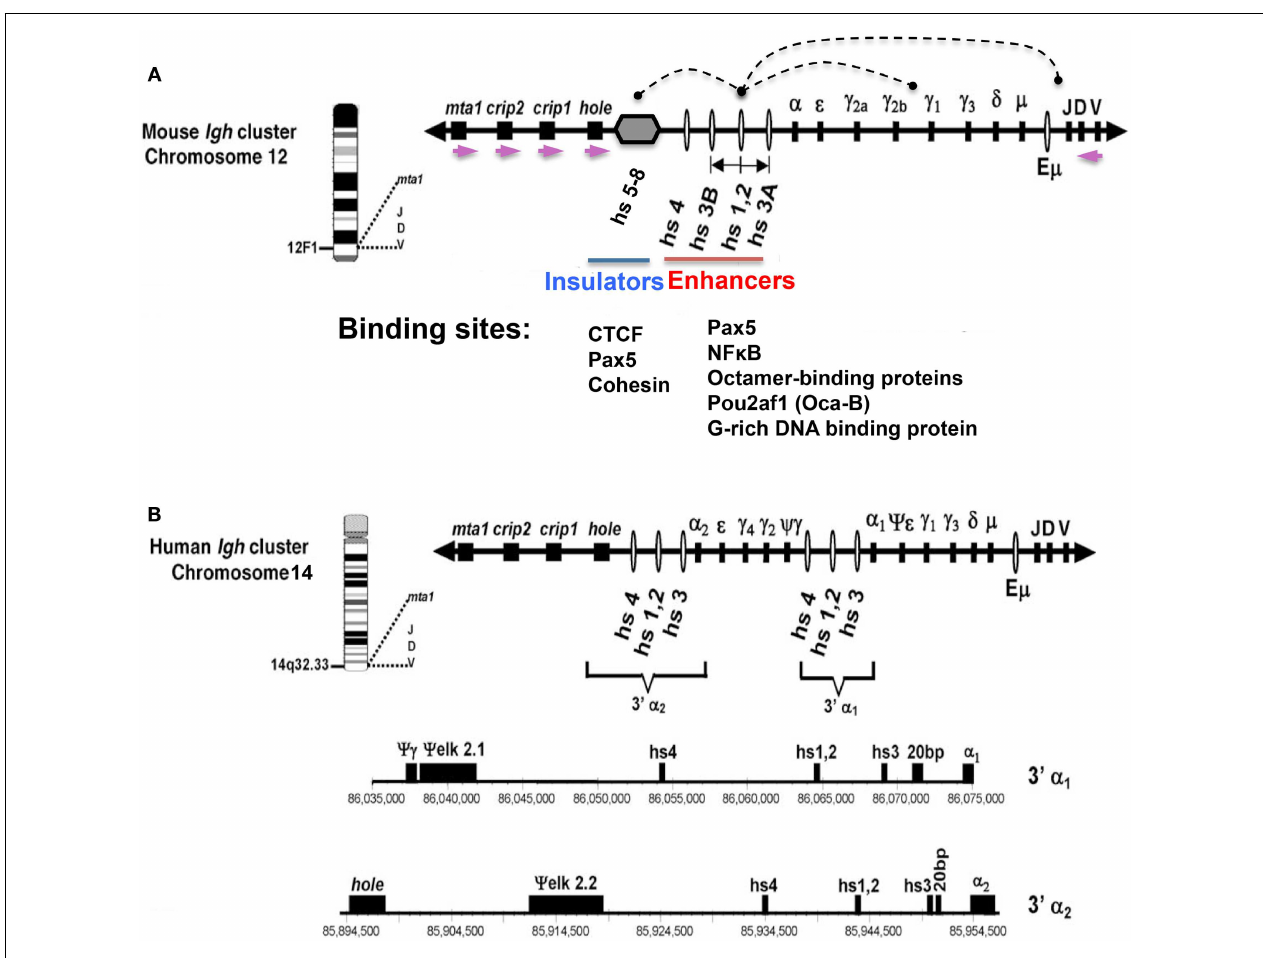
cells among the elements of the 3 (cid:48) RR, and between these elements and regulators of germline transcripts (GT) that are located upstream of switch sequences associated with each C H gene, or with the expressed VDJ gene. Transcription factor binding sites for Pax5, NF κ B, octamer-binding proteins, and a G-rich DNA binding protein are present in each of the 3 (cid:48) RR enhancers (4) (red line).The CTCF-binding region (blue line) has binding sites for Pax5 and cohesin in addition to CTCF (5). (B) The human 3 (cid:48) Igh enhancers and other features are shown to scale under the scheme of the locus. Numbers represent the actual location within human chromosome 14 (NT_026437.10). This figure has been used with permission from its original publication in Molecular Immunology. Some annotations and modifications have been